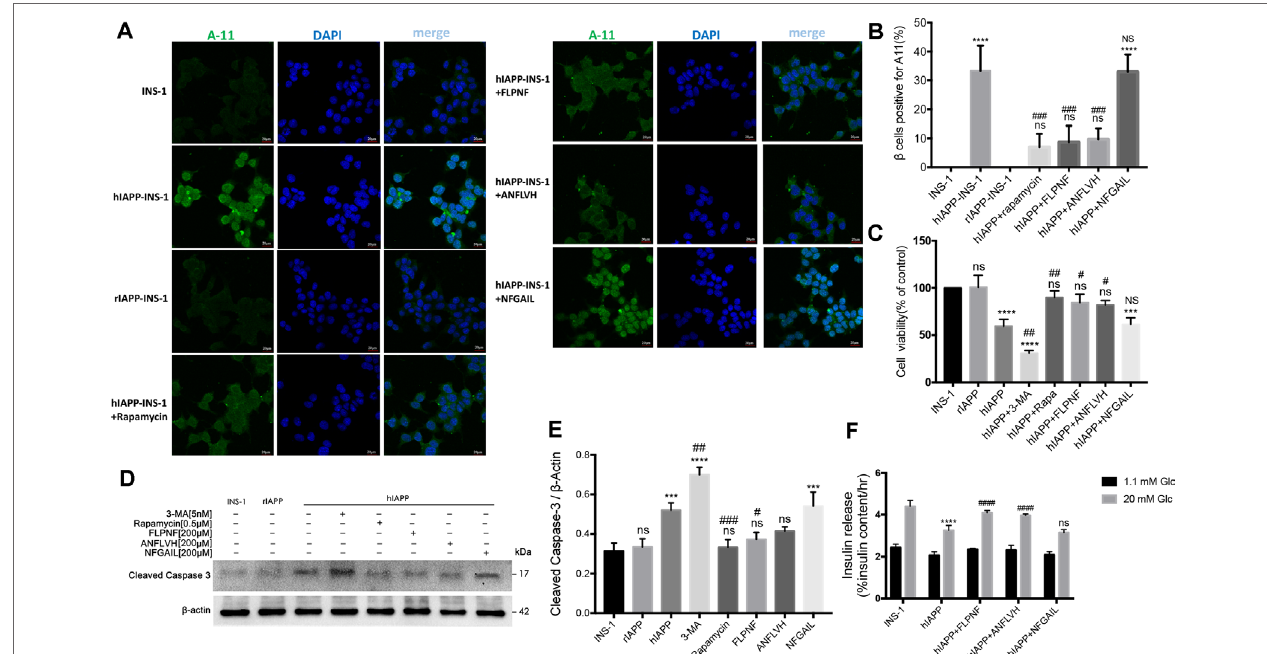
FIGURE 7 | Peptide FLPNF reduces hIAPP oligomer accumulation and protects INS-1 cells from hIAPP cytotoxicity. (A) Fluorescence microscopy images of hIAPP oligomer stained with anti-oligomer antibody A11 (oligomer, green; nuclei, blue). (B) The quantification of the percentage of β cells positive for cytosolic A11, indicated as bright green puncta deposited around the cell nucleus with larger puncta in the cytoplasm in hIAPP-INS-1 cells (n = 3). **** p < 0.0001 and ns vs. INS-1 cells group. ### p < 0.001 and NS vs. hIAPP-INS-1 cell group. (C) The cellular viability of hIAPP-INS-1 cells after exposure to 200 μM peptide FLPNF for 24 h (n = 4). *** p < 0.001, **** p < 0.0001, and ns vs. INS-1 cells group. # p < 0.05, ## p < 0.01, and NS vs. hIAPP-INS-1 cell group. (D) The protein levels of cleaved caspase 3 was assessed by Western blot after exposure to 200 μM peptide FLPNF for 24 h, and quantification shown in (E) . The band intensities were quantified and statistically analyzed relative to untreated INS-1 cell (n = 4). *** p < 0.001, **** p < 0.0001, and ns vs. INS-1 cell group. # p < 0.05, ## p < 0.01, and ### p < 0.001 vs. hIAPP-INS-1 cell group. (F) Glucose-stimulated insulin secretion assay of cells after exposure to 200 μM peptide FLPNF for 24 h (n = 4). The data are expressed as percentages of total insulin content. **** p < 0.0001 vs. INS-1 cell group. #### p < 0.0001, and ns vs. hIAPP-INS-1 cell